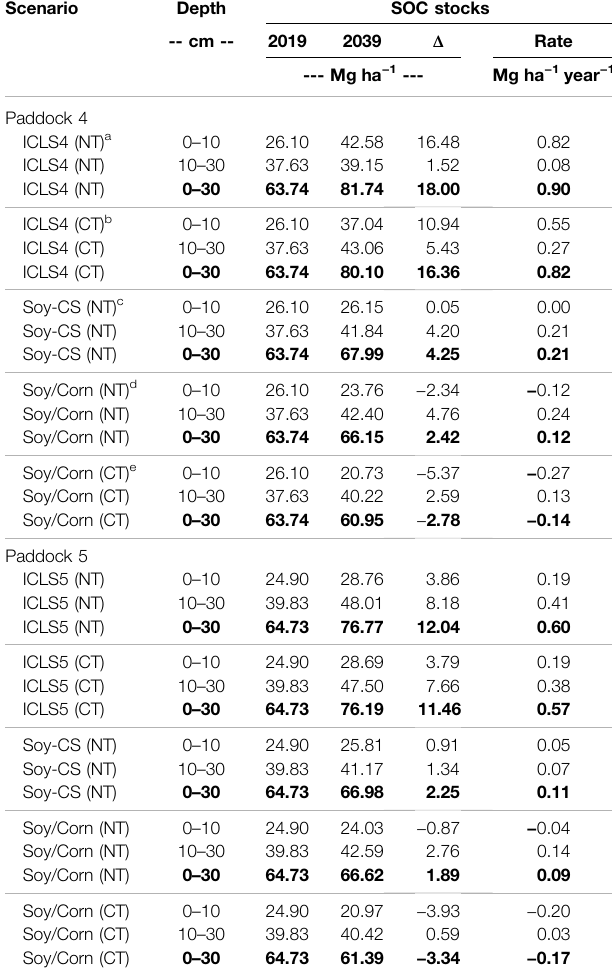
TABLE 4 | Simulated soil organic carbon (SOC) stocks and rate of C changes for Paddock 4 and Paddock 5 between 2019 – 2039 under fi ve management scenarios in a Typic Acrustox soil (Santo Antônio de Goiás, GO, Brazil). Bold values indicate the sum of total SOC content in the top 30-cm